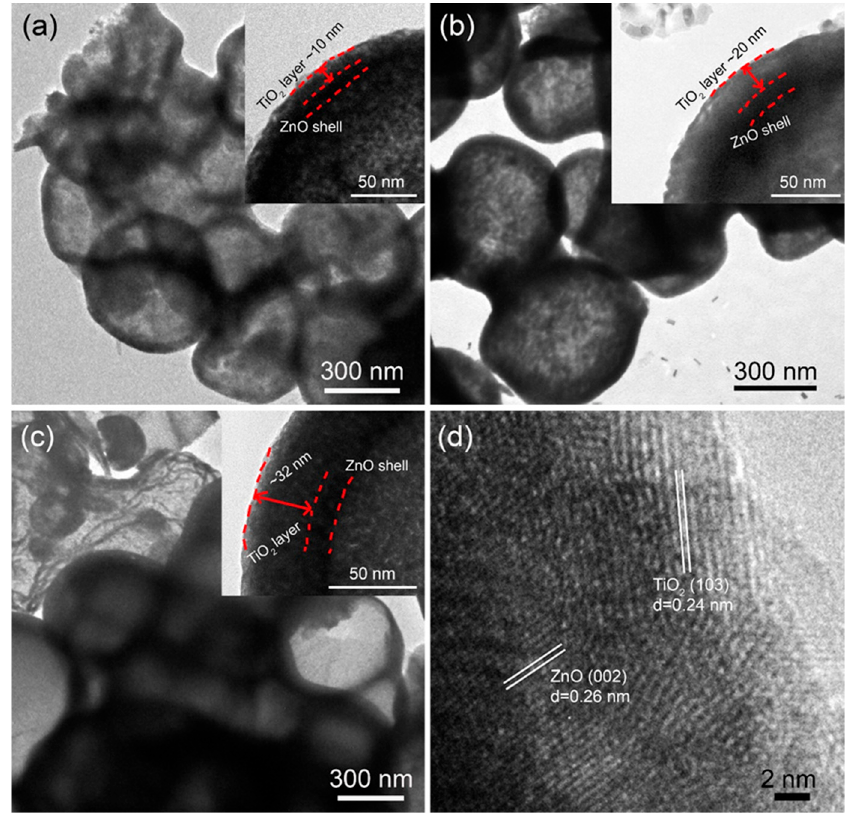
Figure 2. TEM images of TiO 2 -passivated ZnO HMS for different period ( a ) 5-min, ( b ) 10-min, and ( c ) 15-min; ( d ) high resolution TEM image of the TiO 2 -passivated ZnO HMS (10-min). ( c ) 15-min; ( d ) high resolution TEM image of the TiO 2 -passivated ZnO HMS